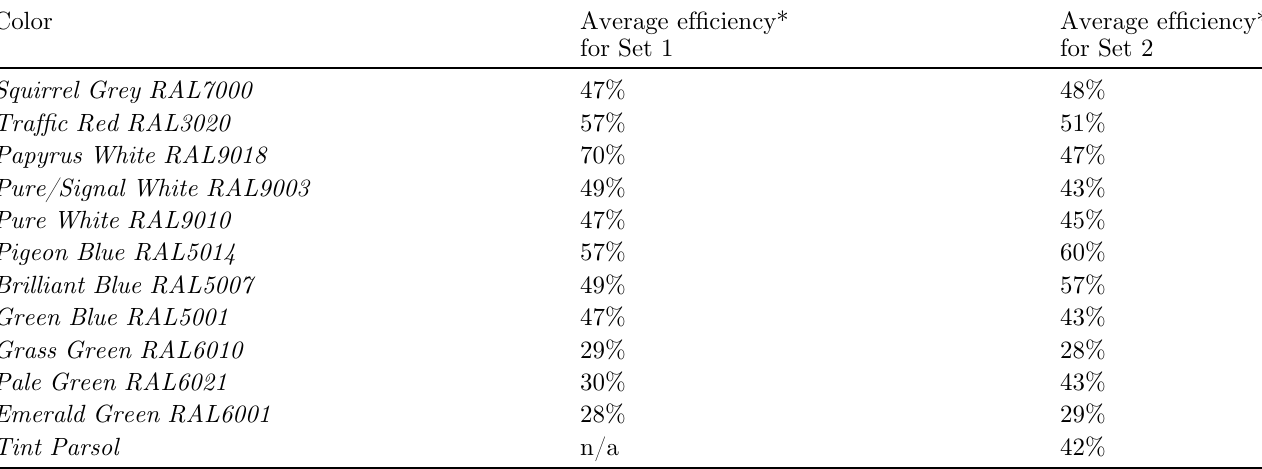
Table 1. Overview of the obtained average ef fi ciencies (compared to non-coated PV glass) from the measured transmittance for the 12 colored coatings of Set 1 and 2.